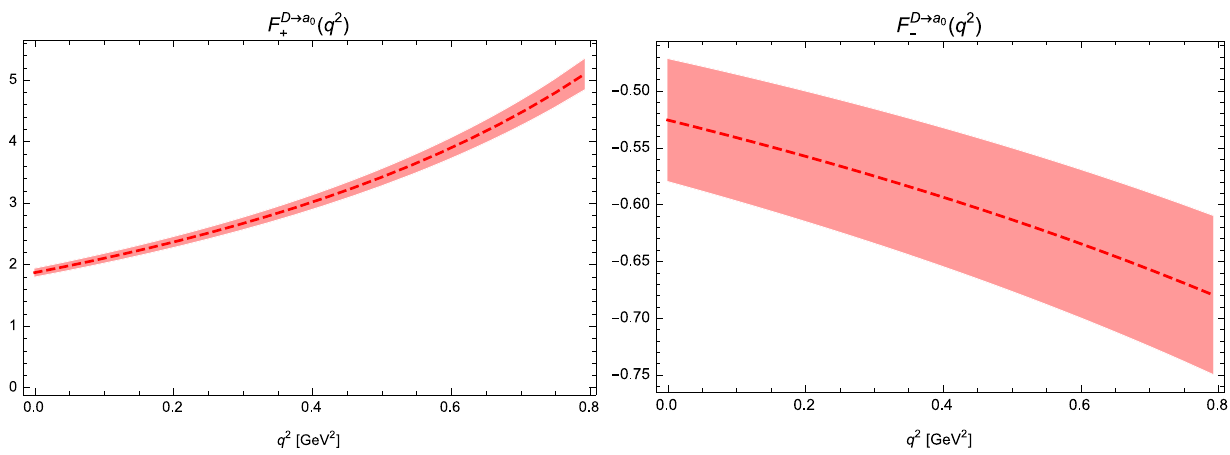
Fig. 4 F + ( q 2 ) (left) and F − ( q 2 ) (right) for the ¯ B 0 decay. The blue bands reflect the uncertainty from the Borel parameter and the LECs of ChPT